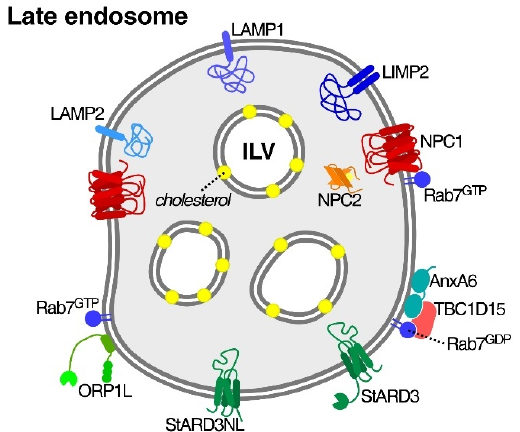
Figure 2. Cholesterol transporters and other proteins contributing to cholesterol export from late endosomes. Abbreviations: ILV, intraluminal vesicles; LAMP1/2, lysosome-associated membrane proteins 1/2; LIMP2, lysosomal integral membrane protein 2; NPC1/2, Niemann–Pick Type C1/2; AnxA6, annexin A6; TBC1D15, Tre-2/Bub2/Cdc16 domain family member 15; ORP1L, OSBP-related protein 1L; StARD3, Steroidogenic acute regulatory (StAR)-related lipid transfer domain containing 3; StARD3NL, StARD3 N ‐ terminal ‐ like protein.